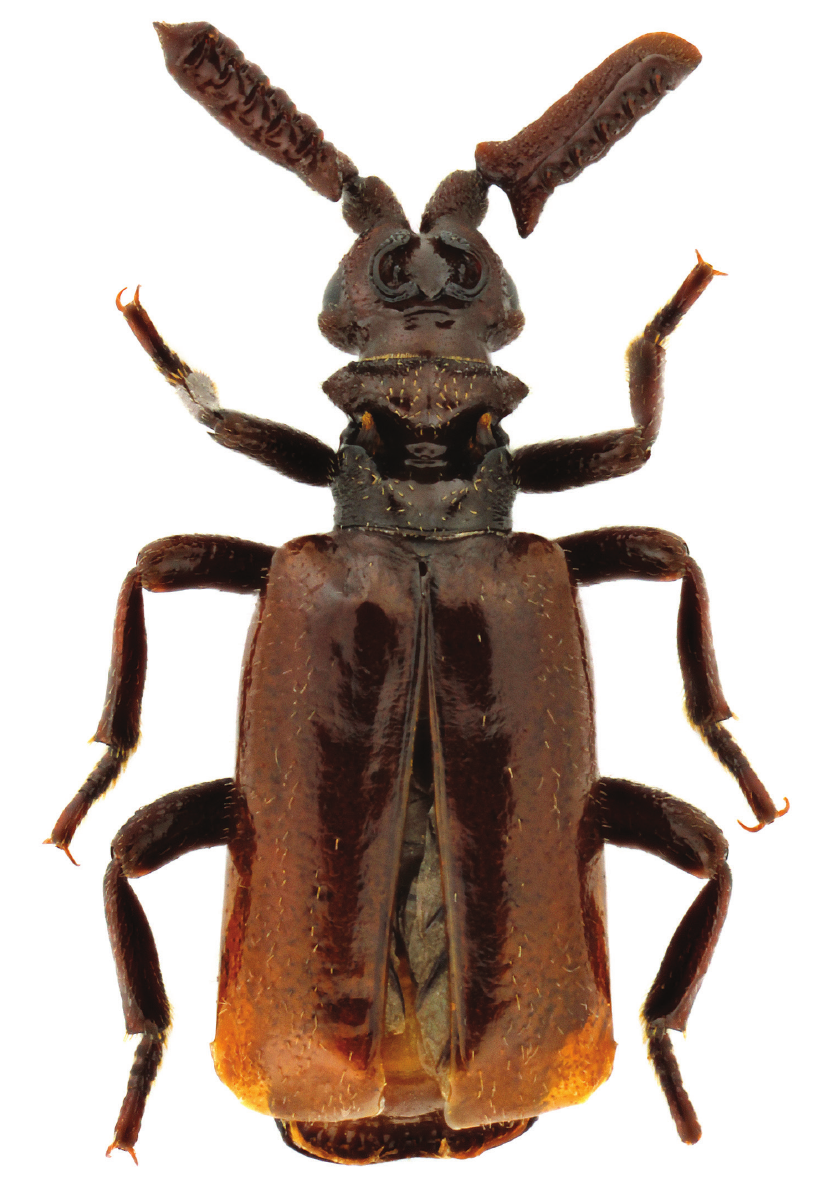
Figure 1. Habitus of Paussus ( Scaphipaussus ) zhouchaoi sp. n. (holotype, ♂ ; dorsal view).